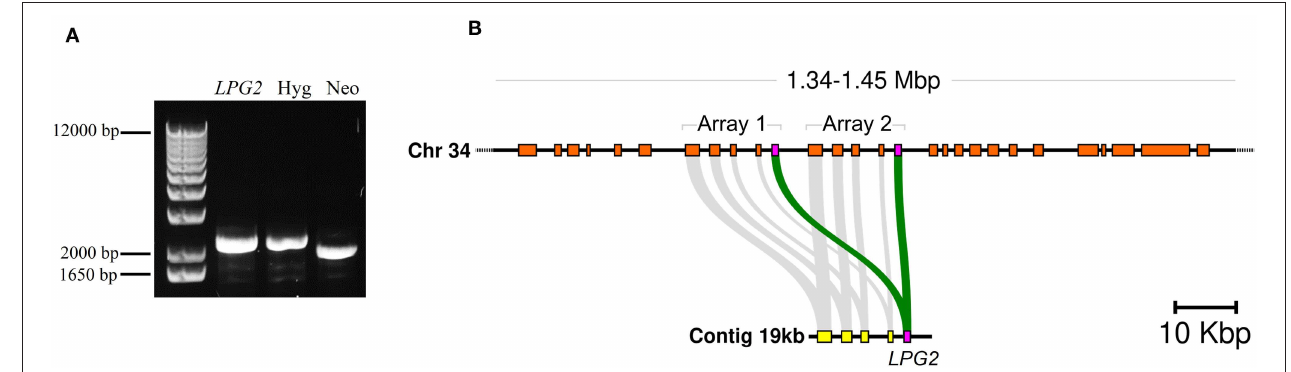
FIGURE 1 | Evidence of LPG2 duplication in L. infantum . (A) Genomic DNA from L. infantum Hyg/NeoR strain was amplified by PCR using specific oligonucleotides ( Supplementary Table 1 ) to verify LPG2 gene targeting by homologous recombination. (B) Comparison of the genomic contexts where LPG2 (magenta box) was originally located (in an unplaced 19 kbp contig shown at the bottom) to the recent resequencing and reassembly of the L. infantum JPCM5 genome (Gonzalez-de la Fuente et al., 2017), where the duplication of the LPG2 gene array is evidenced in chromosome 34 (top). Gray connecting segments indicate sequence conservation, and the coordinates at the top refer to the novel chromosome 34